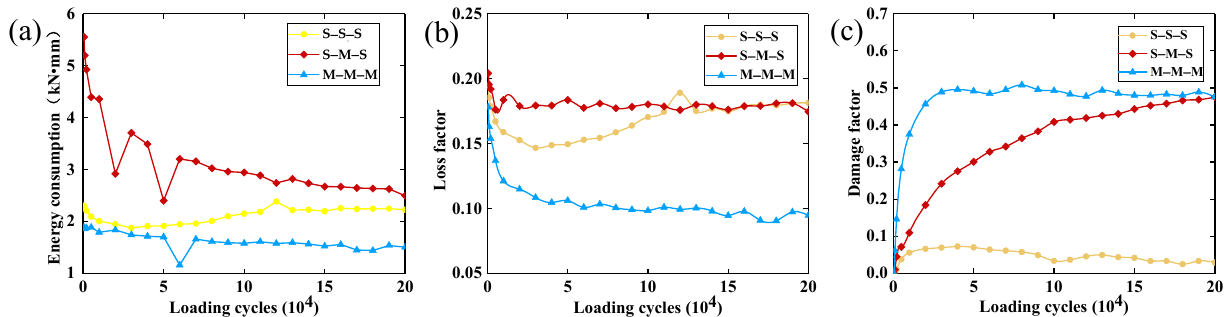
Figure 12. Dynamic performance based on the LCDS: ( a ) Energy consumption; ( b ) L oss factor; ( c ) Damage factor .